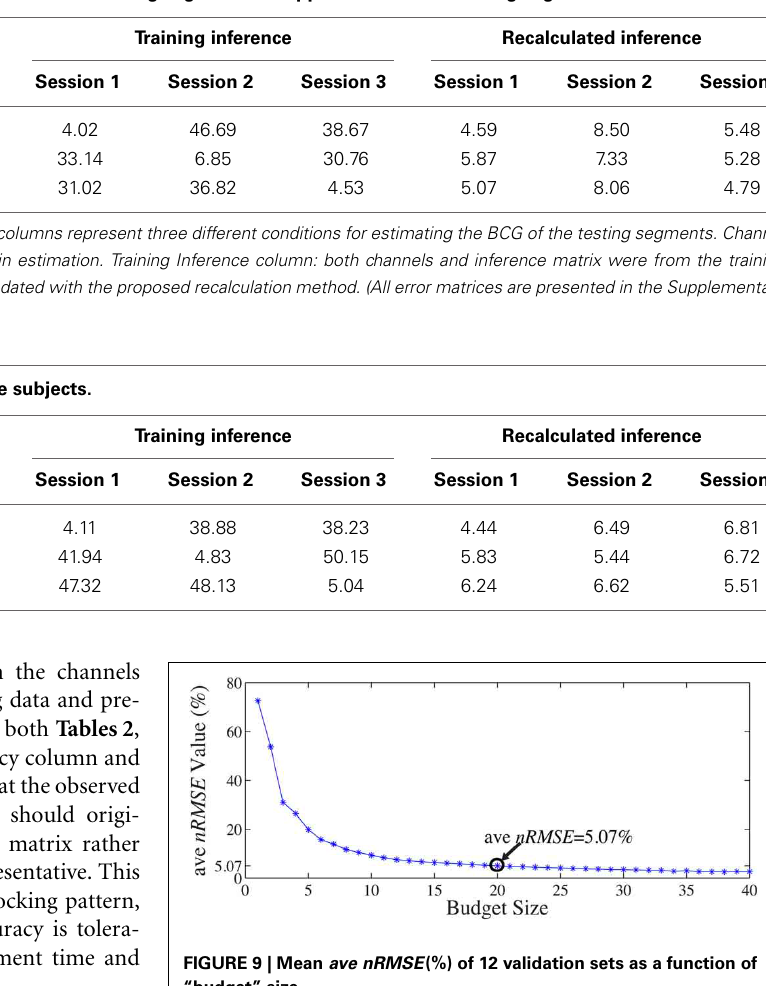
averaged ave nRMSE s over 13 different validation sets